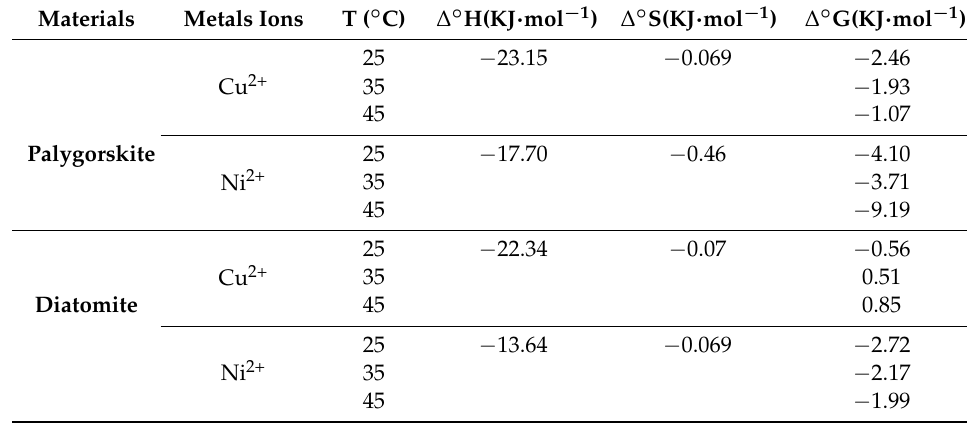
Table 4. Thermodynamic parameters for the adsorption of Cu 2+ and Ni 2+ onto treated diatomite and